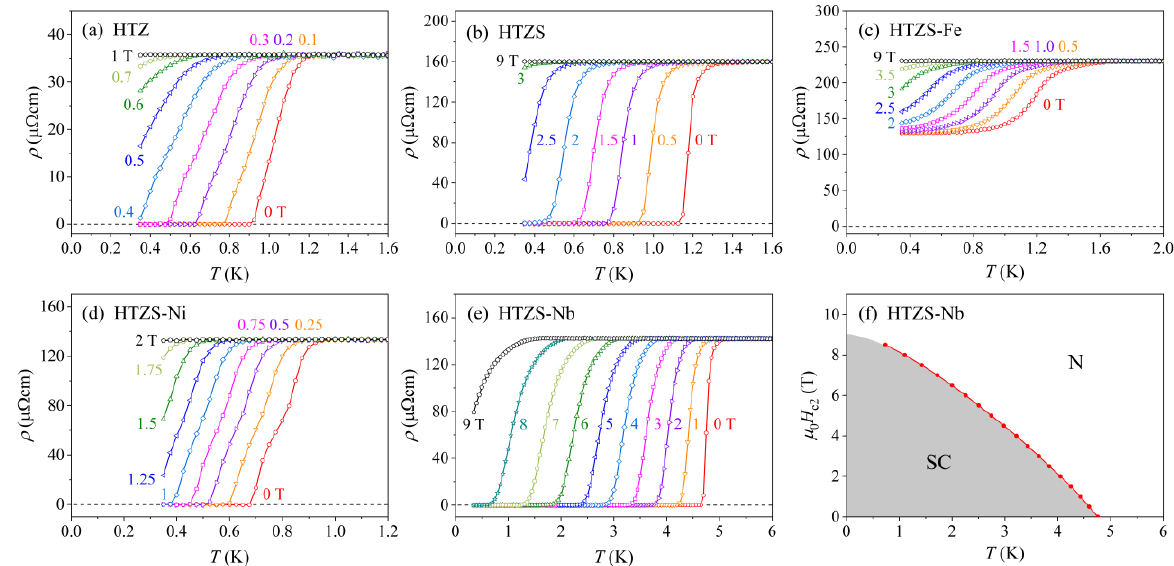
Figure 4. Magnetic-field dependence of the electrical resistivity in the region of the SC transition: ( a ) HfTiZr (HTZ), ( b ) HfTiZrSn (HTZS), ( c ) HfTiZrSnFe (HTZS-Fe), ( d ) HfTiZrSnNi (HTZS-Ni), ( e ) HfTiZrSnNb (HTZS-Nb). ( f ) Temperature dependence of the upper critical field H c 2 ( T ) for the HfTiZrSnNb (HTZS-Nb) alloy, determined from the electrical resistivity (N-normal region, SC-superconducting region).